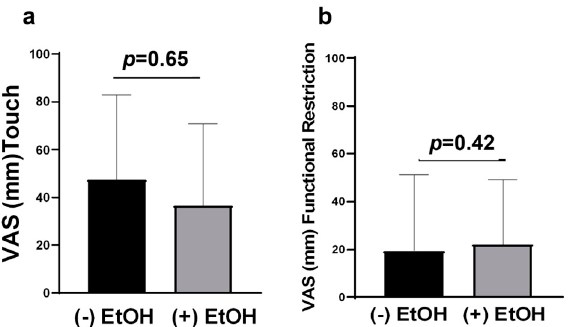
Figure 5. ( a ) VAS scores for pain in response to touch (Q9) (+/ − ) EtOH consumption; x = 36.65 (+) EtOH vs. 47.40 ( − ) EtOH. ( b ) VAS scores for functional restriction (Q10) (+/ − ) EtOH consumption; x = 22.12 (+) ETOH vs. 19.40 ( − )